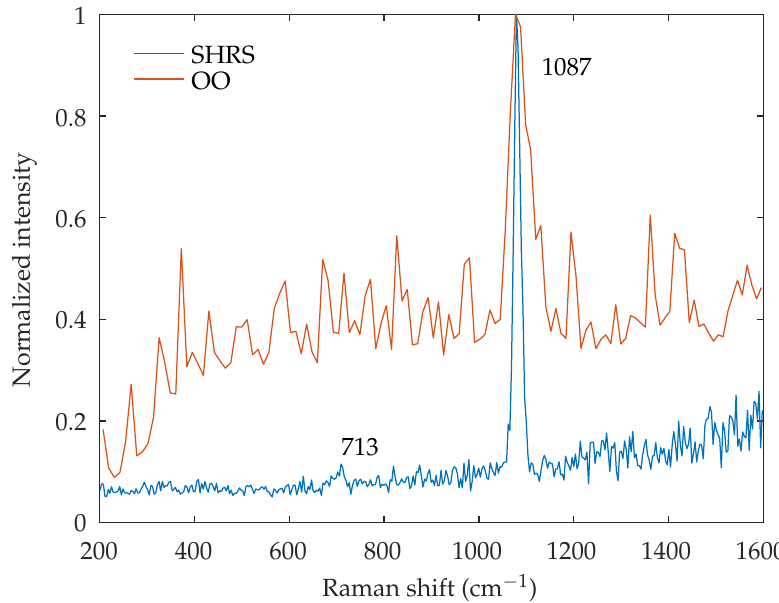
Figure 11. Raman spectrum of calcite (CaCO 3 ), obtained from the marble sample. SHRS refers to the spectrum obtained by the SHRS, and OO refers to the spectrum obtained by the dispersive spectrometer (Ocean Optics modular spectrometer). The SNR from SHRS for the bands at 713 and 1087 cm − 1 is approximately 10 and 60, respectively. The values for SNR from the dispersive spectrometer were 10 and 50, respectively.